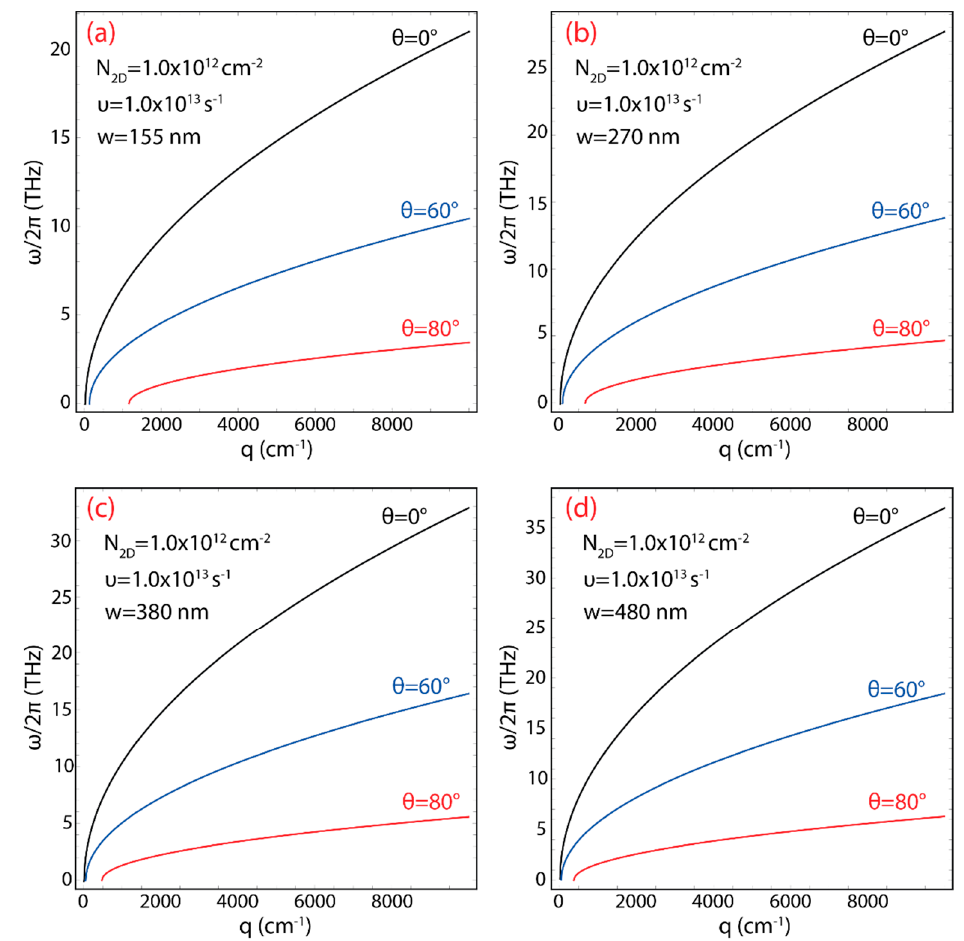
Figure 7. Plasmon frequency dispersion ( ω /2 π ) vs. wave vector ( q ) (using N 2 D = 1.0 × 10 12 cm − 2 , ν = 1.0 × 10 13 s − 1 , and v F = 0.829 × 10 6 m s − 1 ) for different orientations of plasmon momentum ( θ = 0, 60, 80) with different ribbon widths: ( a ) w = 155 nm, ( b ) w = 270 nm, ( c ) w = 380 nm, and ( d ) 𝑤 = 480 nm.